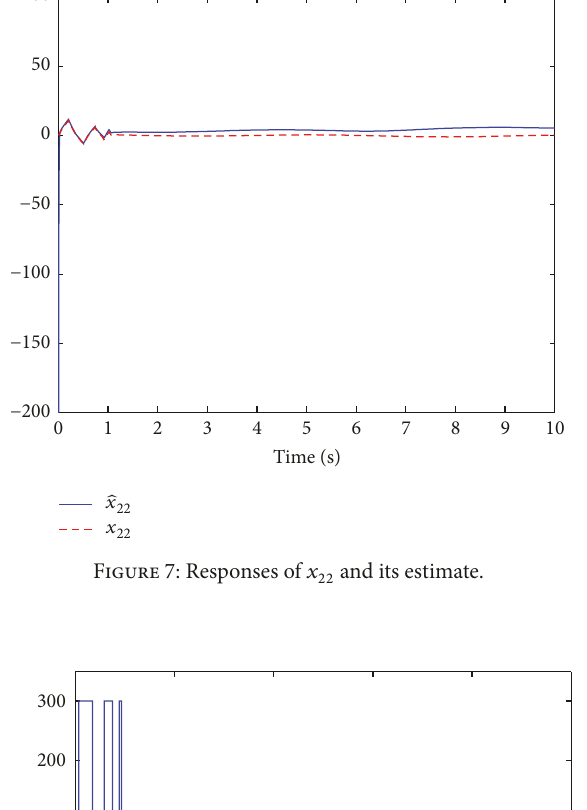
Figure 7: Responses of 𝑥 22 and its estimate.